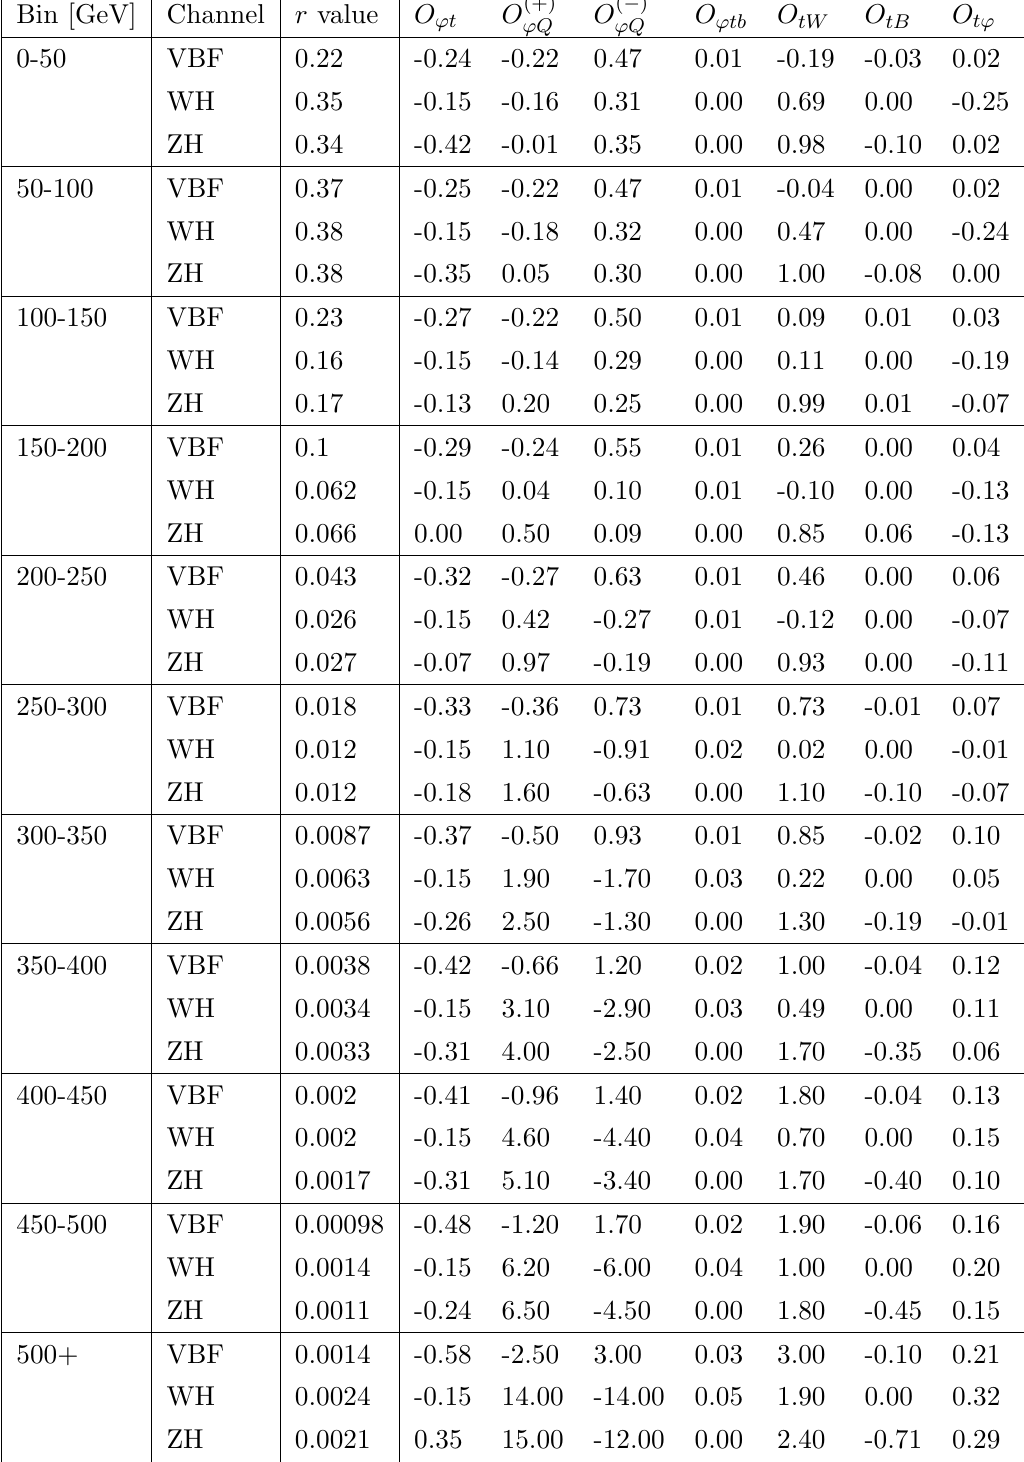
Table 16 . r values and percentage deviations (cid:22) ij for VBF, WH and ZH production in 11 bins of the p T ( H ) distribution at (cid:22) EFT = 125